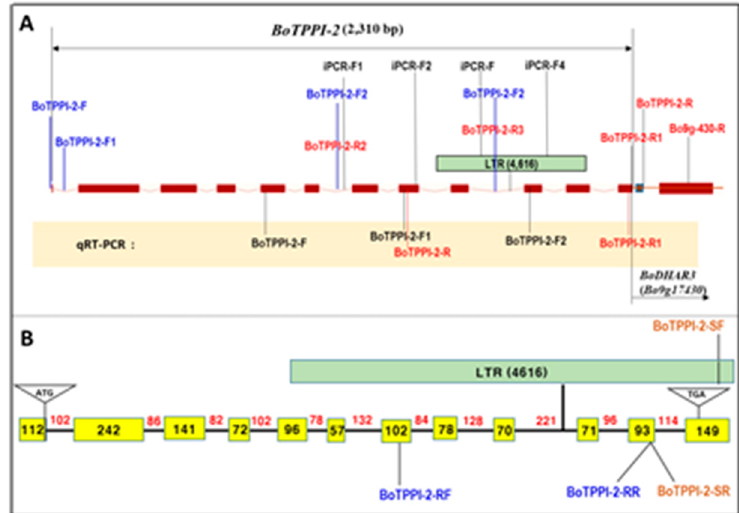
Figure 4. Schematic representation of the BoTPPI-2 gene and adjacent regions along with the names and binding sites of primers used for cloning, RT-PCR, and marker development. ( A ) Genomic structure of the BoTPPI-2 gene and the 5 ′ region of BoDHAR3 (Bo9g17430). The binding sites of primers used for cloning, inverse PCR (iPCR), and qRT-PCR are shown. ( B ) Names and binding sites of primers used for marker development. Long terminal repeat (LTR; 4616 bp) was inserted into the ninth intron of BoTPPI-2_BN2 in the reverse orientation.